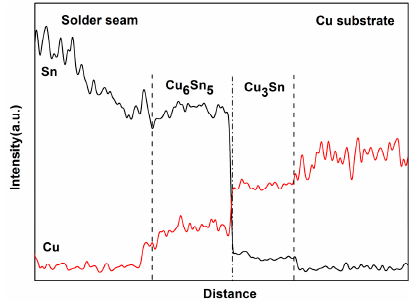
Figure 4. Elemental counts of the line “1” in Figure 2.